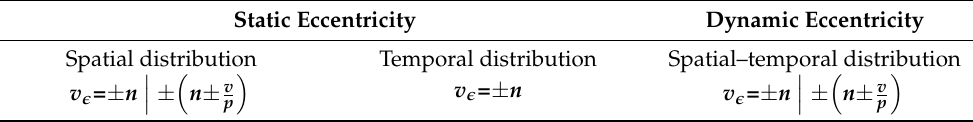
Table 8. Harmonics of the air-gap flux density in a machine with